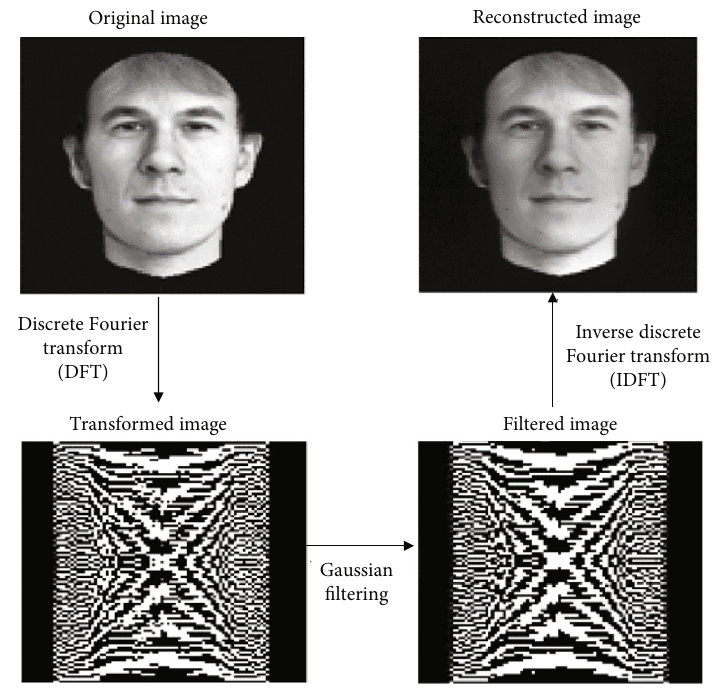
Figure 5: FFT preprocessing